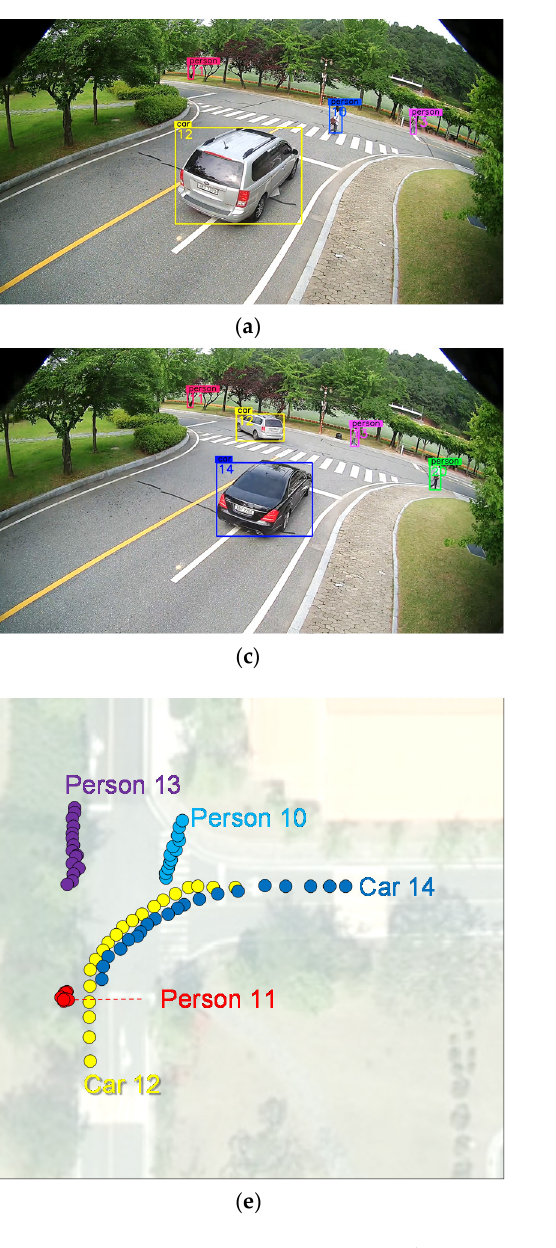
Figure 10. Approaches to compressing data for individual mobility objects: the ( a ) 1st; ( b ) 33rd; ( c ) 66th; ( d ) 100th frame of the closed-circuit television video in our testbed; ( e ) result of sampling the entire frame to 1/5 size; ( f ) curve-fitting result of the sampled positions [29].